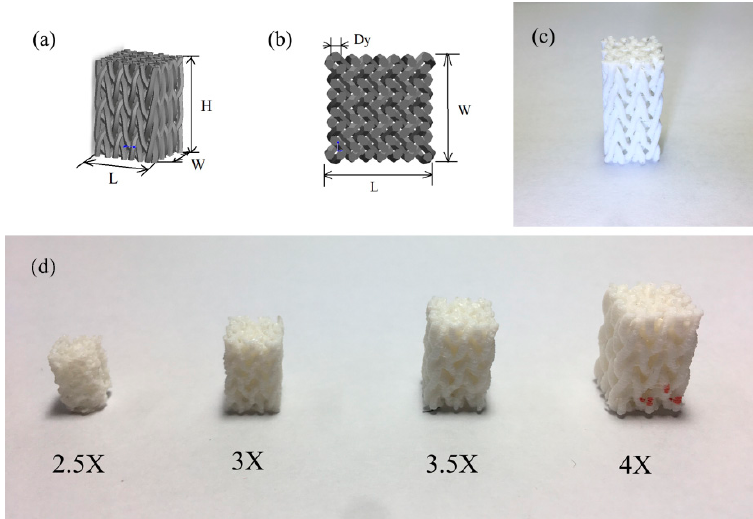
Figure 3. Braiding structure CAD model: ( a ) isometric view of braiding structure (L, W, H are the length, width, and height of the braiding structure); ( b ) top view of braiding structure (L, W are the length and width of the braiding structure, D y is the diameter of the yarn in the braiding structure); ( c ) printed braiding structure with PLA filament; ( d) experiment to ensure the fidelity of the printed specimen (from left to right: the yarn diameter in the braiding structure was amplified 2.5, 3, 3.5, and 4 times, respectively).